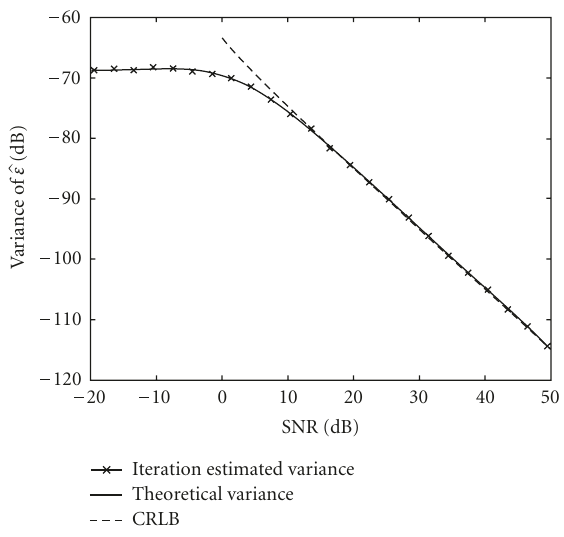
Figure 2: One iteration estimated variance of the time-scaling fac- tor estimation according to the SNR, it is compared to theoretical variance and CRLB. The estimated variance is calculated on a set of 1000 independent signals with an applied time-scaling factor of − 5 · 10 − 3 .